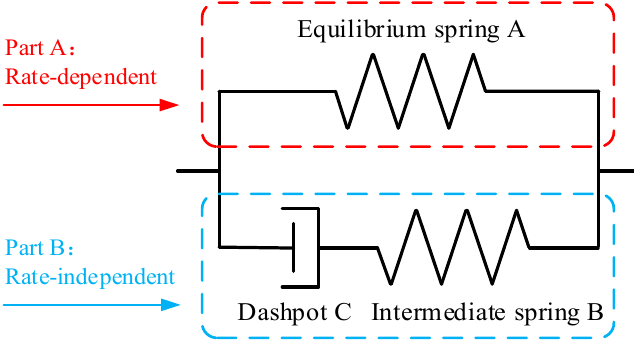
Figure 2. Illustration of the hyper-viscoelastic model.